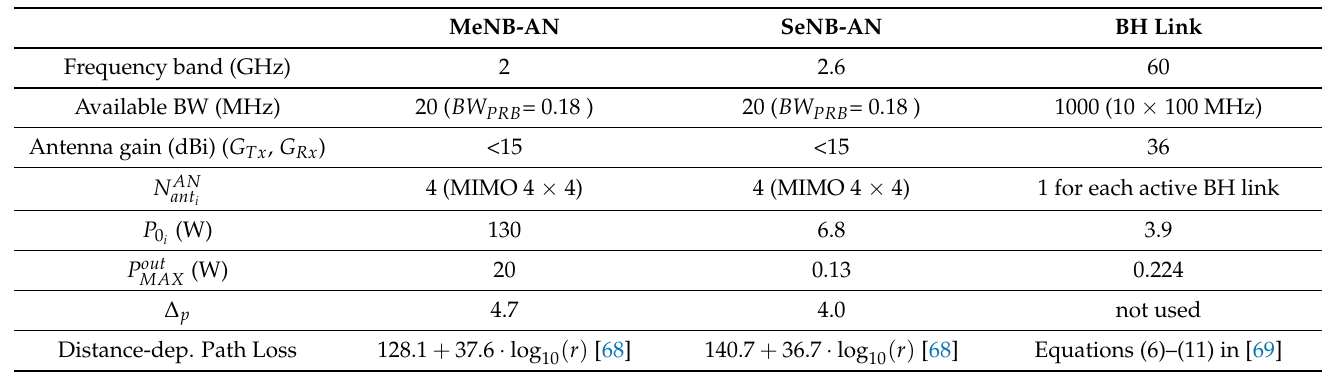
Table 3. Parameters used for